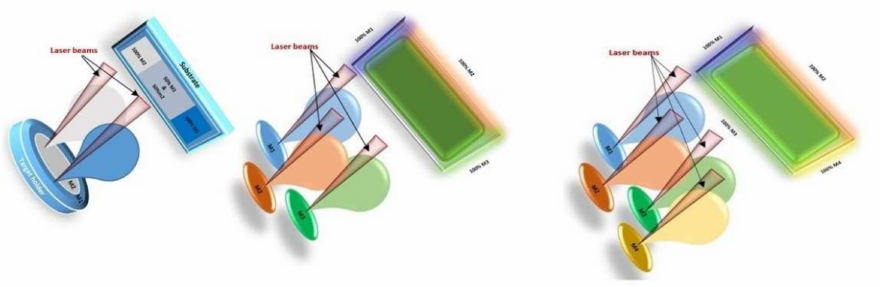
Figure 8. Experimental configuration for obtaining C-MAPLE thin films using two, three, or four targets (reproduced after